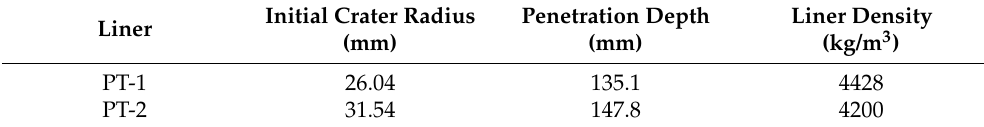
Table 5. Penetration test